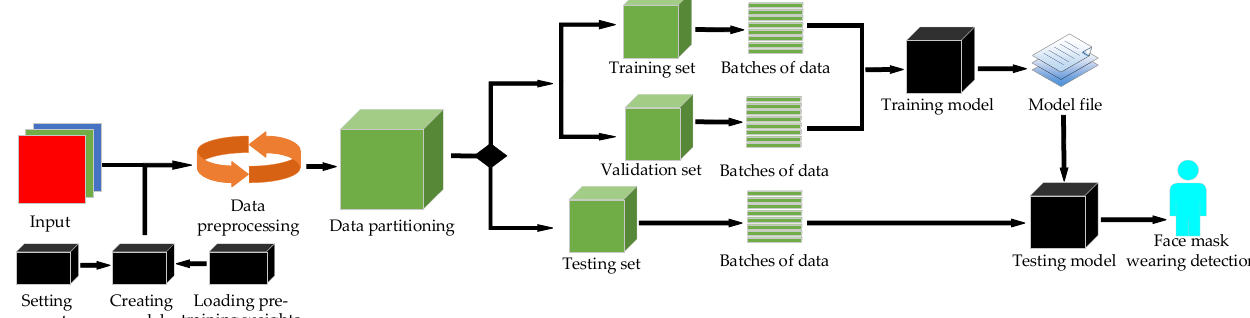
Figure 1. Flow chart of the proposed approach.